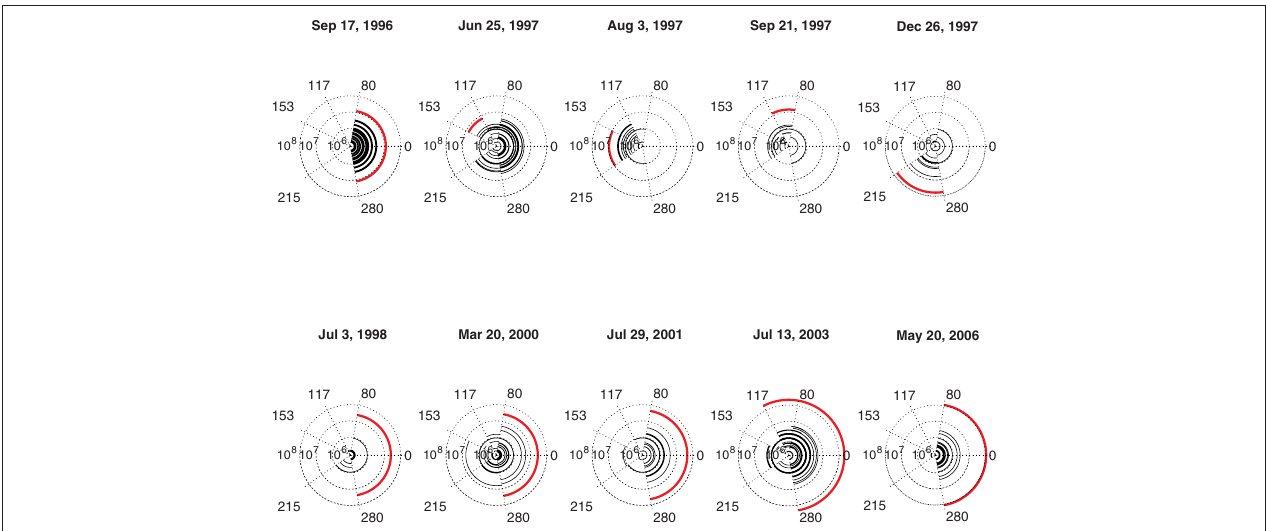
6 m 3 ). Thin black arcs indicate